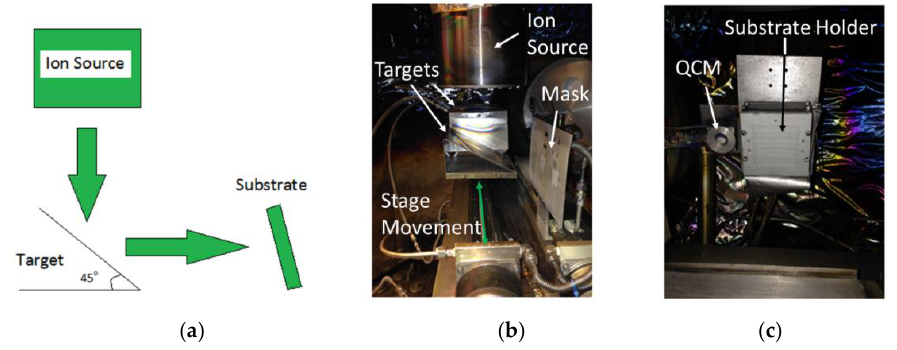
Figure 1. Configuration for the sputtering chamber: ( a ) is a schematic; ( b ) is a photograph showing the direction of target movement where the substrate holder is behind the mask; ( c ) is a photograph of the substrate holder viewed perpendicularly to the target motion. The quartz crystal micrograph (QCM) is used to measured film thickness.